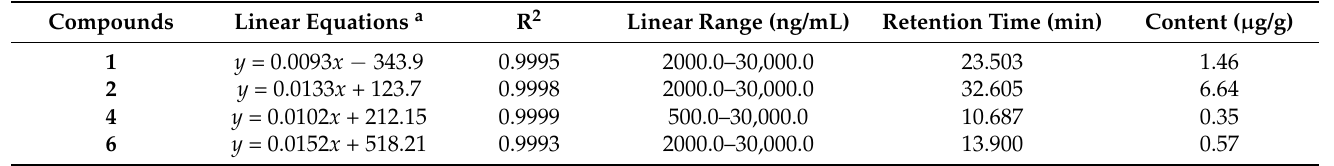
Table 1. Regression equations, correlation coefficients, linear range, retention time, and contents for the four